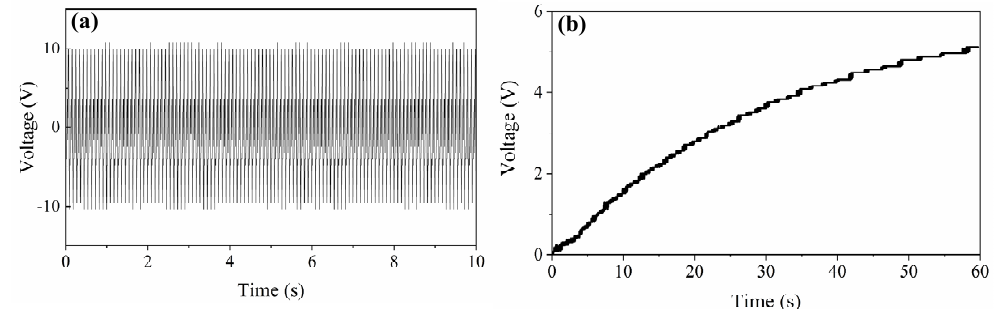
Figure 13. Applying proposed PVEH in harvesting sustained vibration. ( a ) Output voltage of pro- posed PVEH; ( b ) The voltage over charged capacitor.